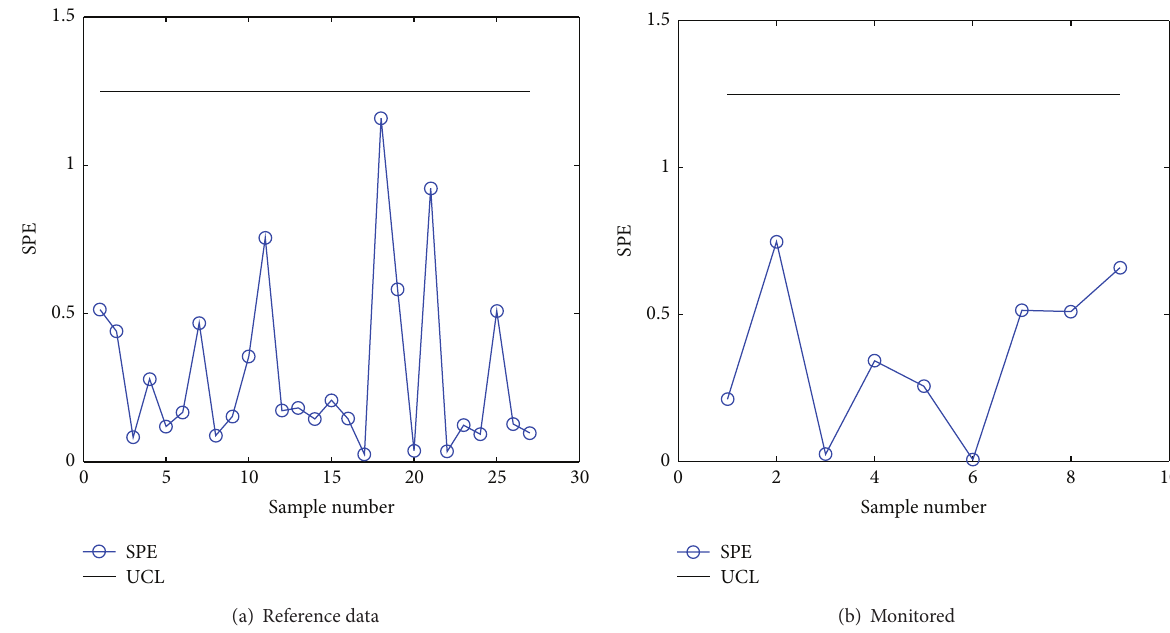
Figure 11: Monitoring charts of KPCA using COMAC.